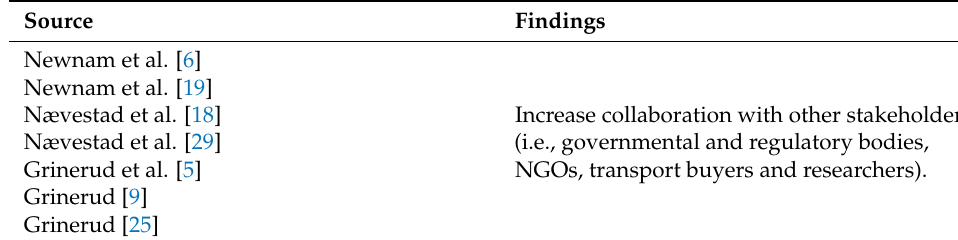
Table 5. Third-party organizations and regulatory bodies.